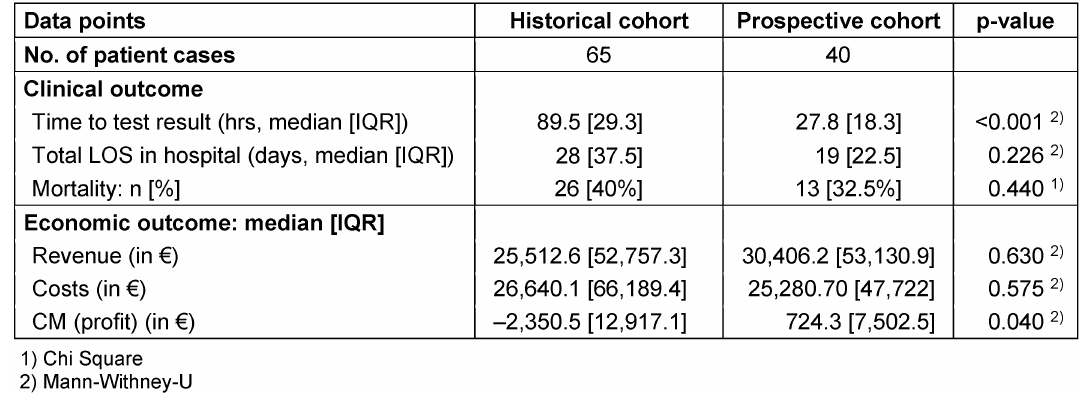
Table 5: Clinical and economic outcomes of patients in the PP